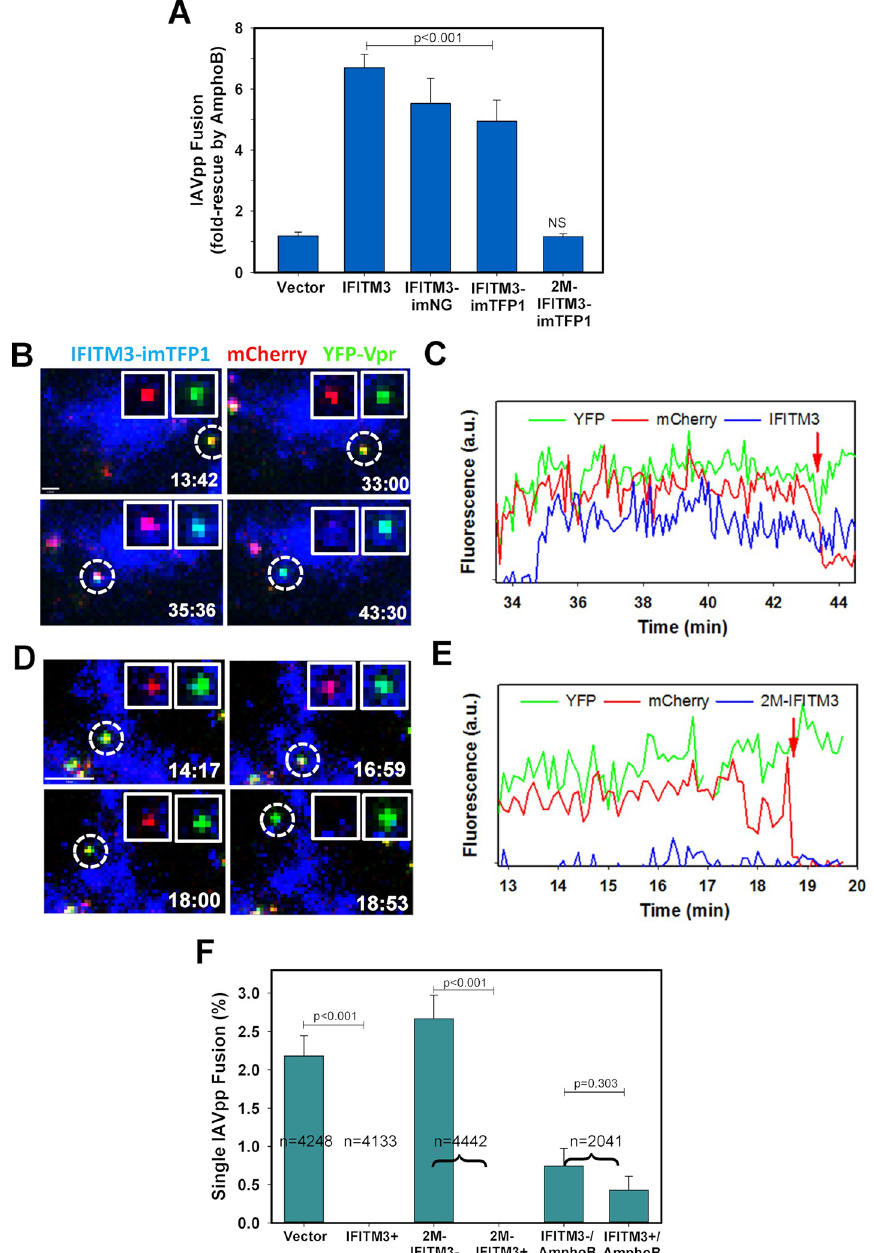
Fig 4. Amphotericin B treatment allows IAV fusion with IFITM3-containing endosomes. (A) AmphoB rescues IAVpp fusion with IFITM3 expressing cells. IAVpp carrying BlaM-Vpr were used to infect A549 Vector, IFITM3, IFITM3-imNeonGreen (IFITM3-imNG), IFITM3-imTFP1, or 2M-IFITM3-imTFP1 cells in the presence of 1 μ M AmphoB and viral fusion was measured by the BlaM assay. Data are fold-increase compared to fusion in the absence of AmphoB and SEM from 2 independent triplicate experiments. Lack of significant AmphoB effect on IAVpp fusion with unlabeled IFITM3 versus 2M-IFITM3-imTFP1 expressing cells is associated with their relatively high permissiveness for IAV fusion (see Fig 1F). (B) IAVpp carrying mCherry-2xCL-YFP-Vpr were imaged with A549-IFITM3-imTFP1 cells treated with 1 μ M AmphoB. Time-lapse images show the viral particle entering an IFITM3+ compartment around 35 minutes and co-trafficking with IFITM3-imTFP1 until fusion occurs around 43 minutes. Scale bar 1.3 μ m. (C) A fluorescence trace corresponding to the fusion event in panel C in the presence of AmphoB. (See S8 Movie). (D) Double-labeled IAVpp were pre-bound to 2M-IFITM3-imTFP1 cells as in (B). Images show IAVpp in an IFITM3+ cell that does not co-traffic with IFITM3+ compartments. Scale bar 5.9 μ m. (E) Fluorescence traces for a single particle fusion in 2M-IFITM3-imTFP1 cells corresponding to the particle in panel